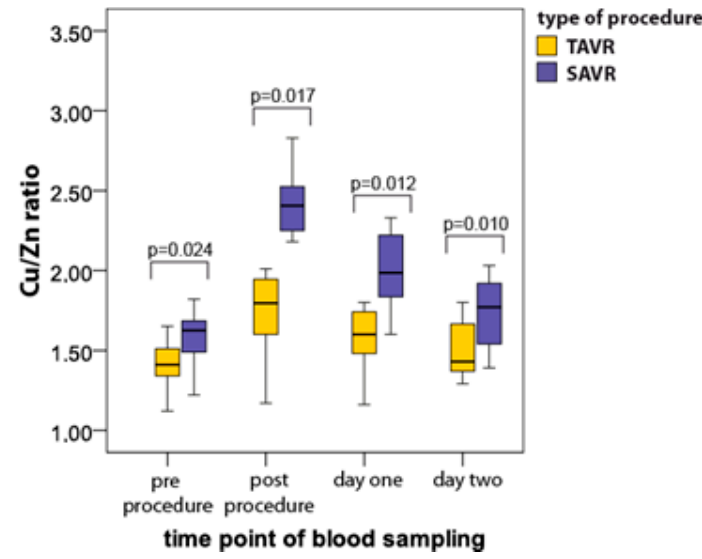
Figure 3. Serum Cu / Zn ratio (median with interquartile range) in patients undergoing TAVR ( n = 12) and SAVR ( n = 12) procedures.